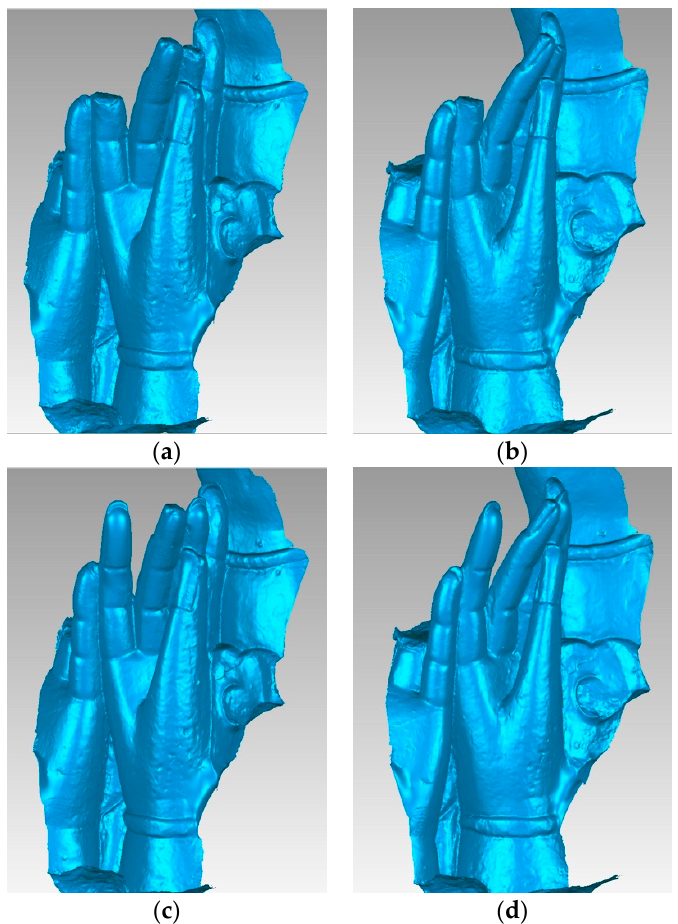
Figure 15. Virtual restoration effect of ID 9-7-s4 hand: ( a , b ) original model; ( c , d ) virtual restoration effect.